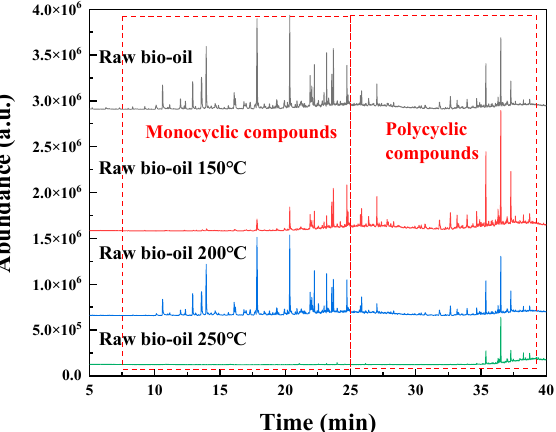
9 of 19 Figure 8. Cumulative molecular weight distribution of raw bio-oil hydrodeoxygenation at 150 °C, 200 °C, and 250 °C. GC-MS is mainly used to detect the light components in bio-oil. (The light compo- nents refer to water-soluble components, including small molecular ketones, aldehydes, phenols, acids, etc. The heavy components refer to water-insoluble components, such as polycyclic aromatic compounds [30]. The GC-MS results of raw bio-oil hydrodeoxygena- tion products are shown in Figure 9. As the fi gure illustrates, monocyclic compounds in the light components of bio-oil hydrodeoxygenation products decreased at 150 °C and 200 °C and almost disappeared at 250 °C. Nevertheless, at 150 °C and 200 °C, polycyclic aro-